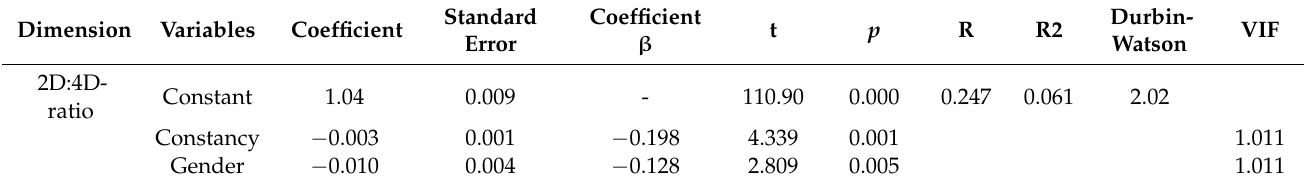
Table 4. Dimensions to predict 2D:4D-ratios; multiple regression